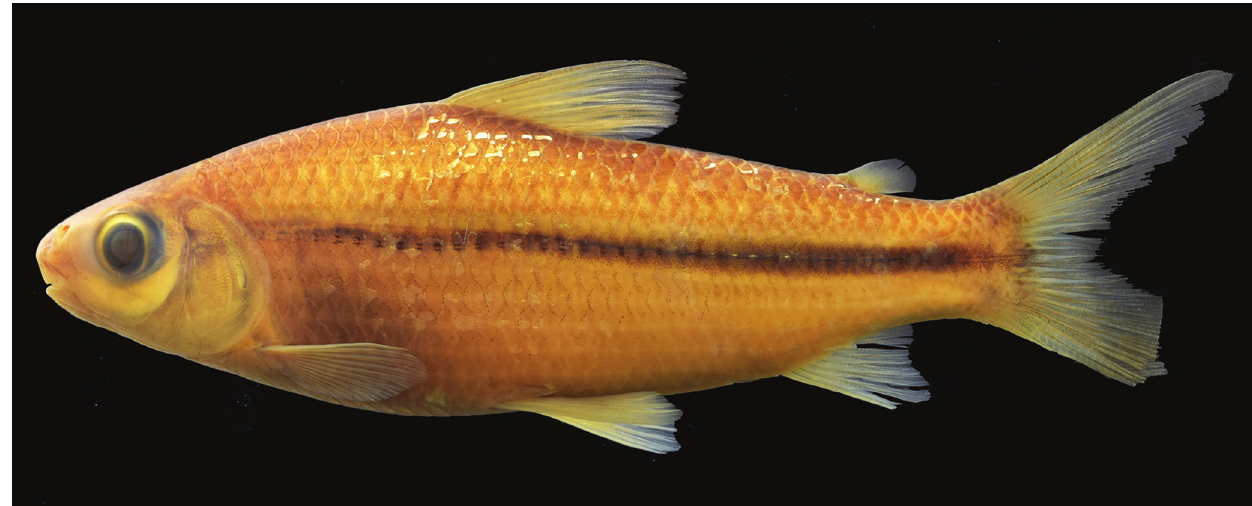
Fig. 6. Steindachnerina insculpta , LBP 11381, 78.7 mm SL, Brazil, São Paulo, Birigui, Rio Tietê, upper Rio Paraná. Diagnosis. Steindachnerina insculpta can be